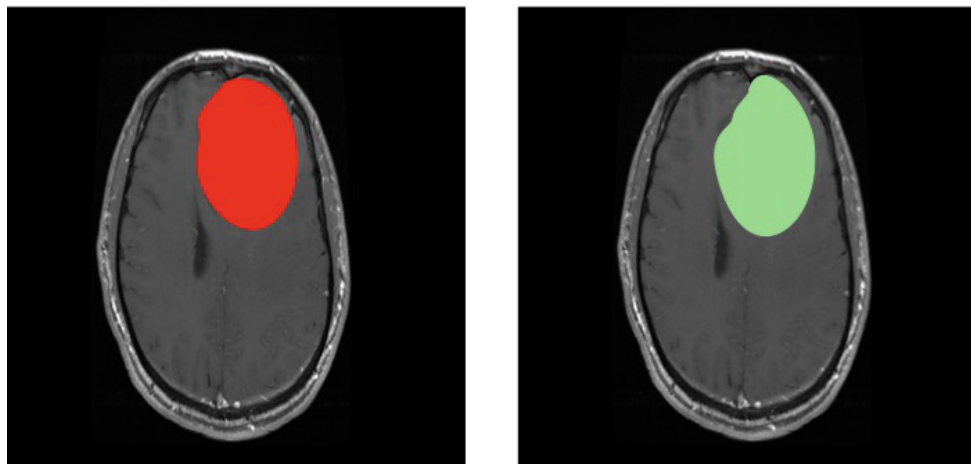
Figure 13. Experimental assessment, third patient, comparisons between the two segmentation methodologies. Left side shows the proposed method, the right side shows Slicer